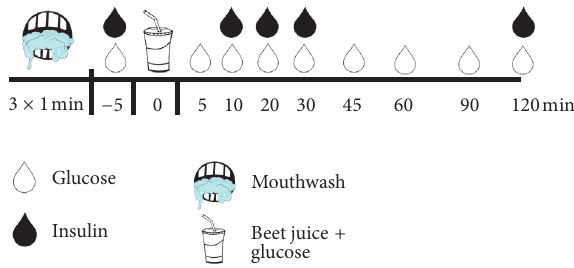
Figure 1: Schematic of experimental visits. Two modified oral glu- cose tolerance tests were administered, on two separate occasions, in a random order. At the start of one visit, participants completed 3 × 1min mouthwash regimen. Without delay, they then ingested beet juice supplemented with glucose within 5 minutes. Venous blood ( ∼ 3–10mL) was sampled repeatedly over 120 minutes and analyzed for concentrations of glucose and insulin. See text for more